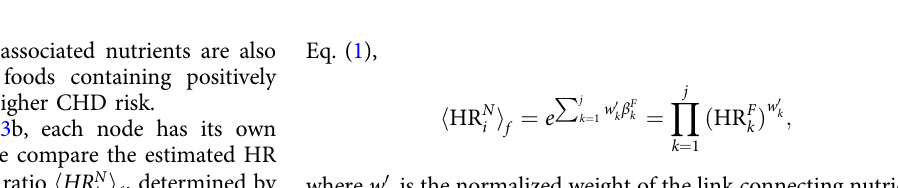
The exposures that are statistically signi fi cant in association with CHD risk are listed. P values are associated with two-sided Wald